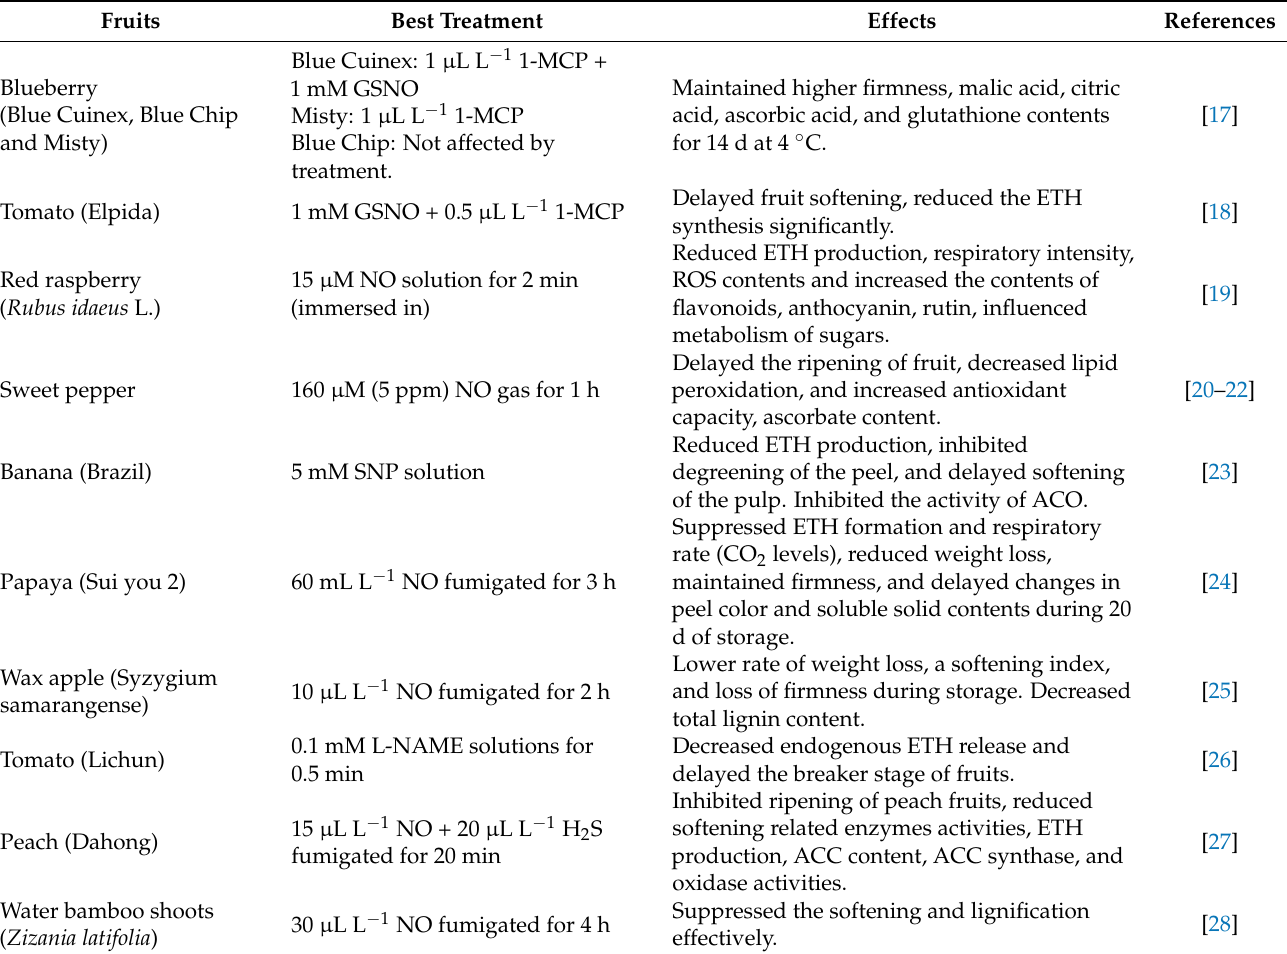
Table 1. The effects of NO treatment on postharvest fruit